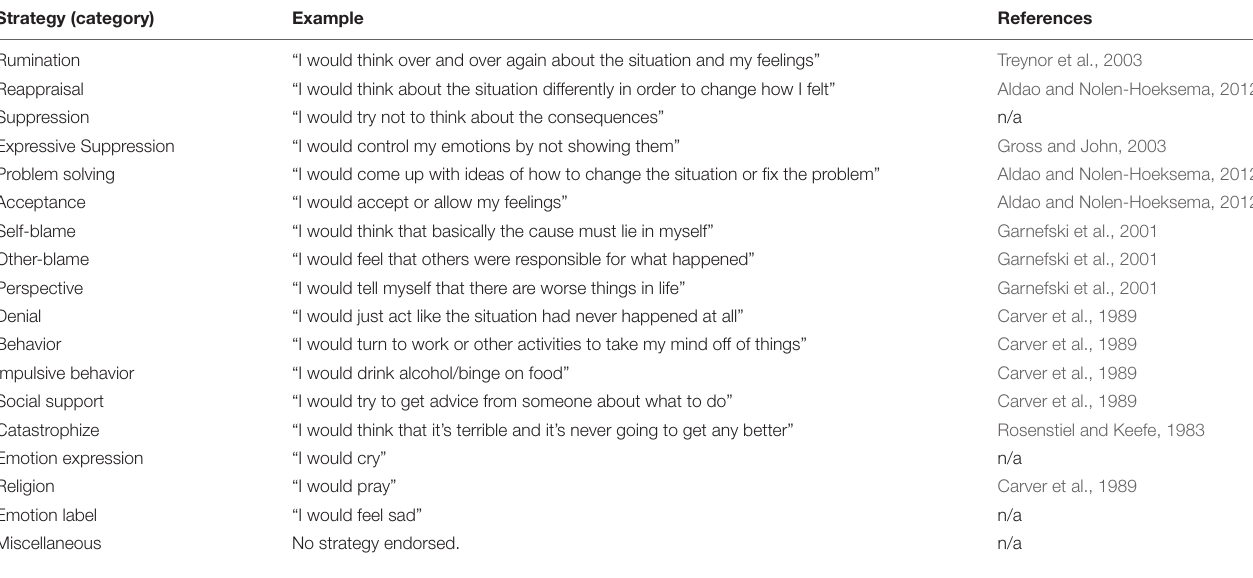
TABLE 2 | Summary of coding scheme: examples of